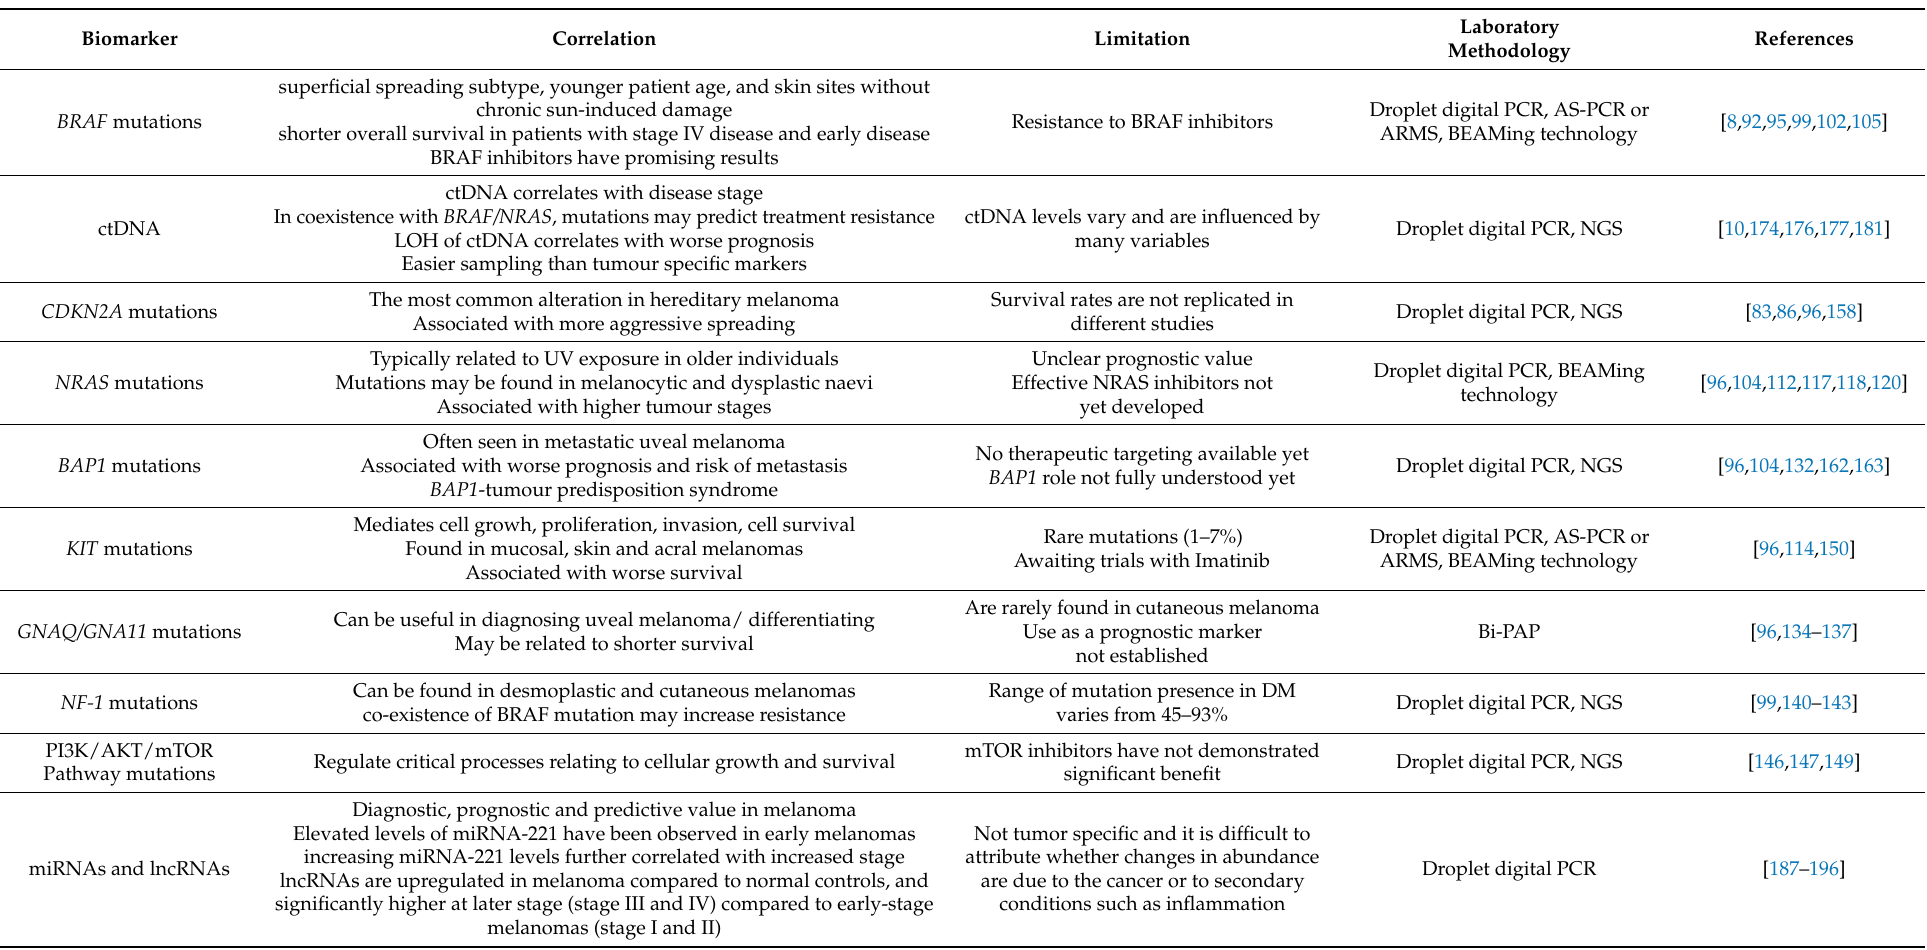
Table 2. DNA Markers and Molecular liquid